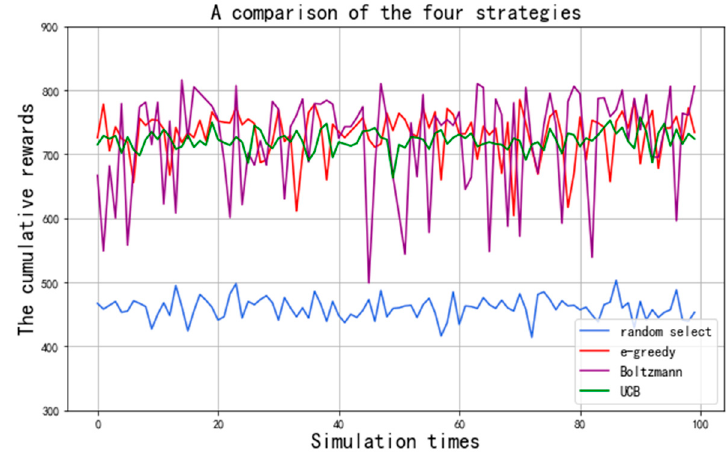
Figure 5. Comparison of four arm selection methods.